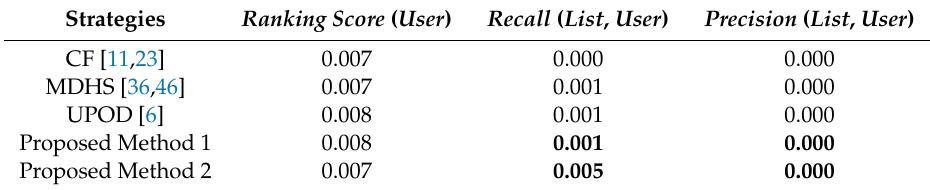
Table 6. Comparison of σ for the proposed methods with existing strategies— Book-Crossing .